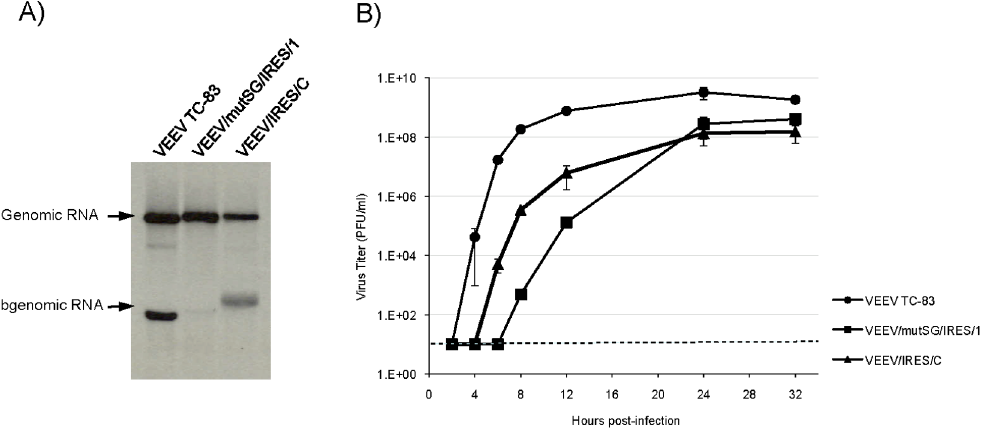
Figure 2. RNA synthesis and replication of VEEV TC-83 and TC-83/IRES constructs in BHK cells after electroporation. (A) Analysis of 3 [H]-labeled viral RNA production and (B) viral replication after transfection of 4 m g of in vitro -synthesized RNA into BHK cells. Dark dashed line indicates the limit of detection for the experiment.